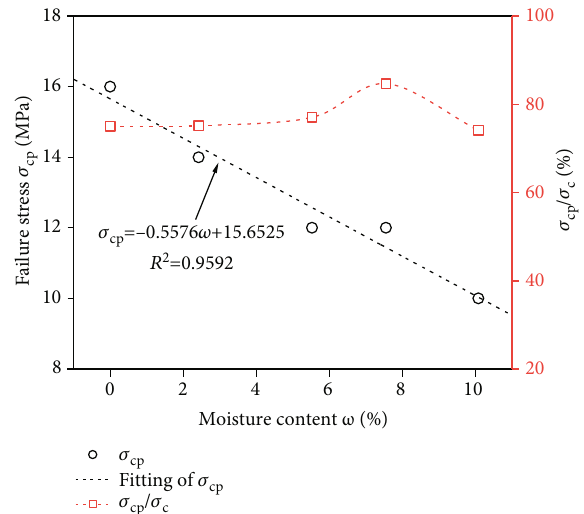
Figure 8: Variation curve of creep failure stress and its proportion with water